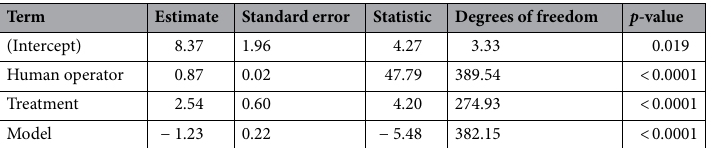
Table 4. Model table for fixed effects in a linear mixed model.